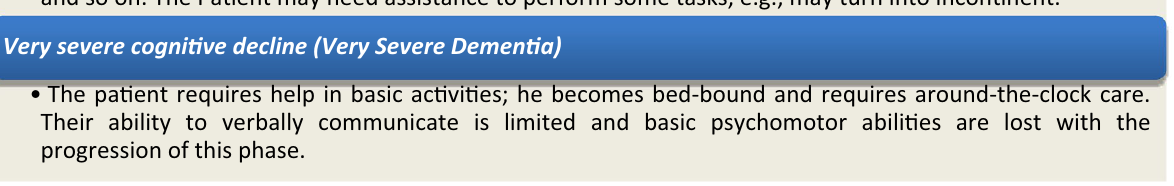
Figure 1. The AD stages according to the global deterioration